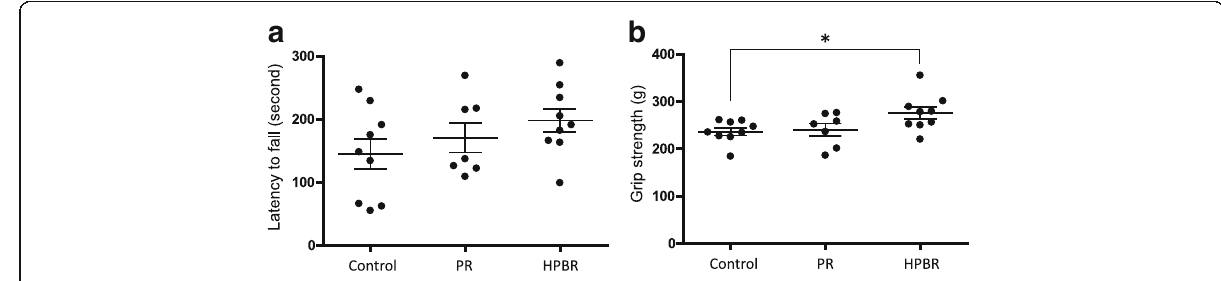
Fig. 4 Evaluation of motor function. a Rota rod test. P = 0.24, one-way ANOVA. b Grip strength test. P = 0.04, one-way ANOVA and * P < 0.05, control vs HPBR, Dunnett ’ s post-test. PR: Polished rice. HPBR: highly water pressurized brown rice. Mean ± SE, n = 9 (control and HPBR